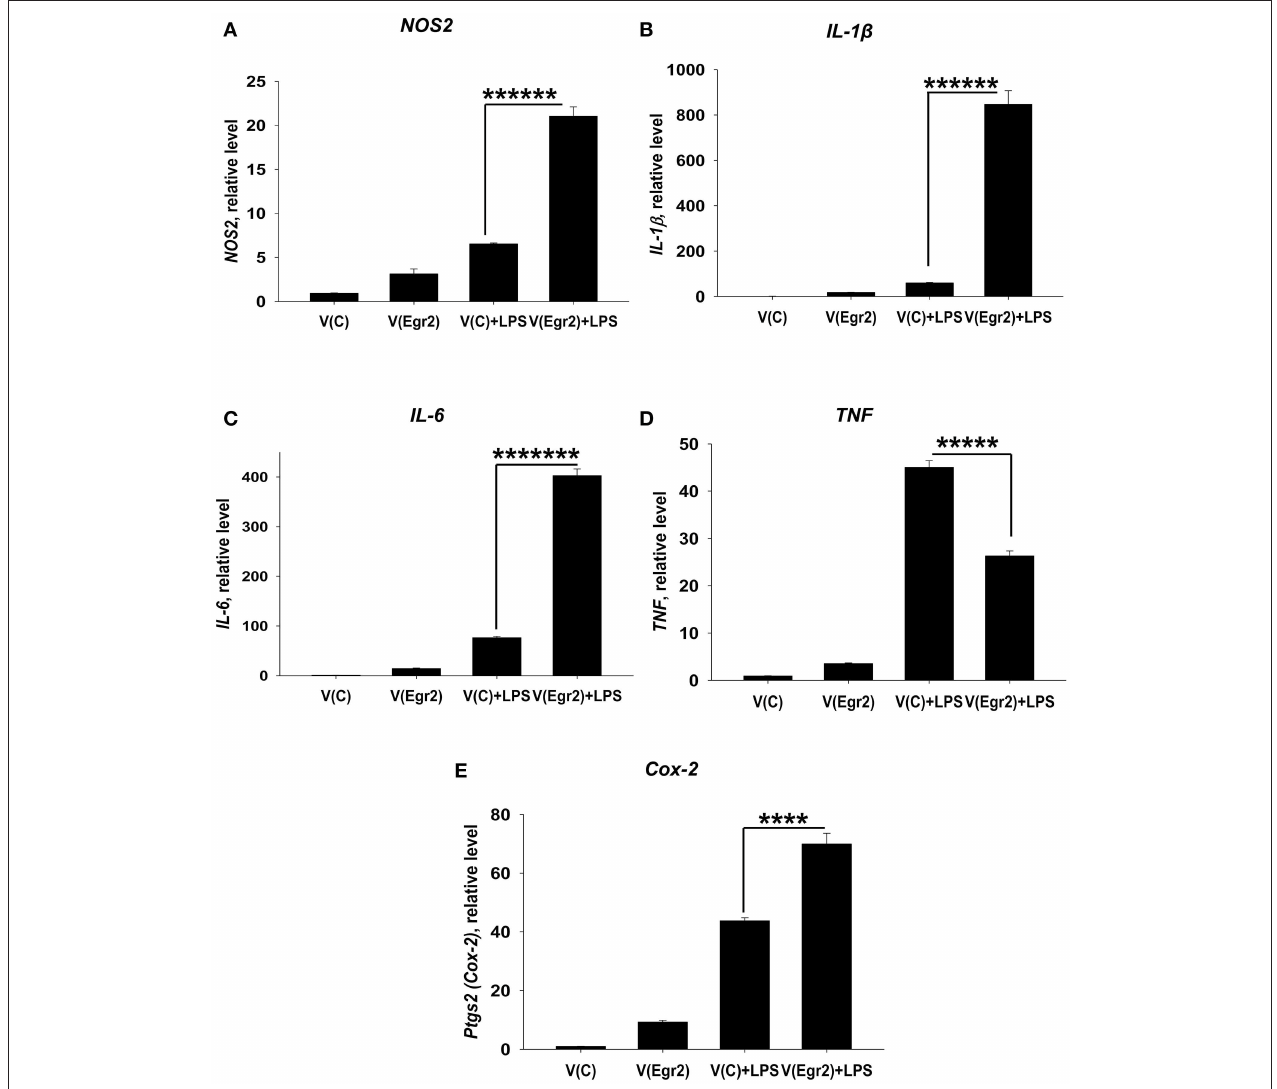
FIGURE 10 | Analysis of expression of M1-associated markers (NOS2, IL-1 β , IL-6, TNF, Cox-2) in LPS-activated macrophage cell line with overexpression of Egr2. Macrophage cell line RAW264.7 was transfected with empty (control) pMIG expression vector plasmid [V(C)] or vector with Egr2 [V(Egr2)] for 24h and after which the cells were used as unstimulated [V(C) and V(Egr2)] or activated with LPS (100ng/ml) for another 24 h-time period [V(C) + LPS and V(Egr2) + LPS] as in Figure 7 . The cells were washed, mRNA was isolated and the expressions of NOS2 (A) , IL-1 β (B) , IL-6 (C) , TNF (D) , Cox-2 (E) were analyzed by real-time PCR as described in Materials and Methods . In (A–E) , mean ± S.E. of six separate culture plate wells is shown (**** p < 0.0001; ***** p < 0.00001; ****** p < 0.000001; ******* p <